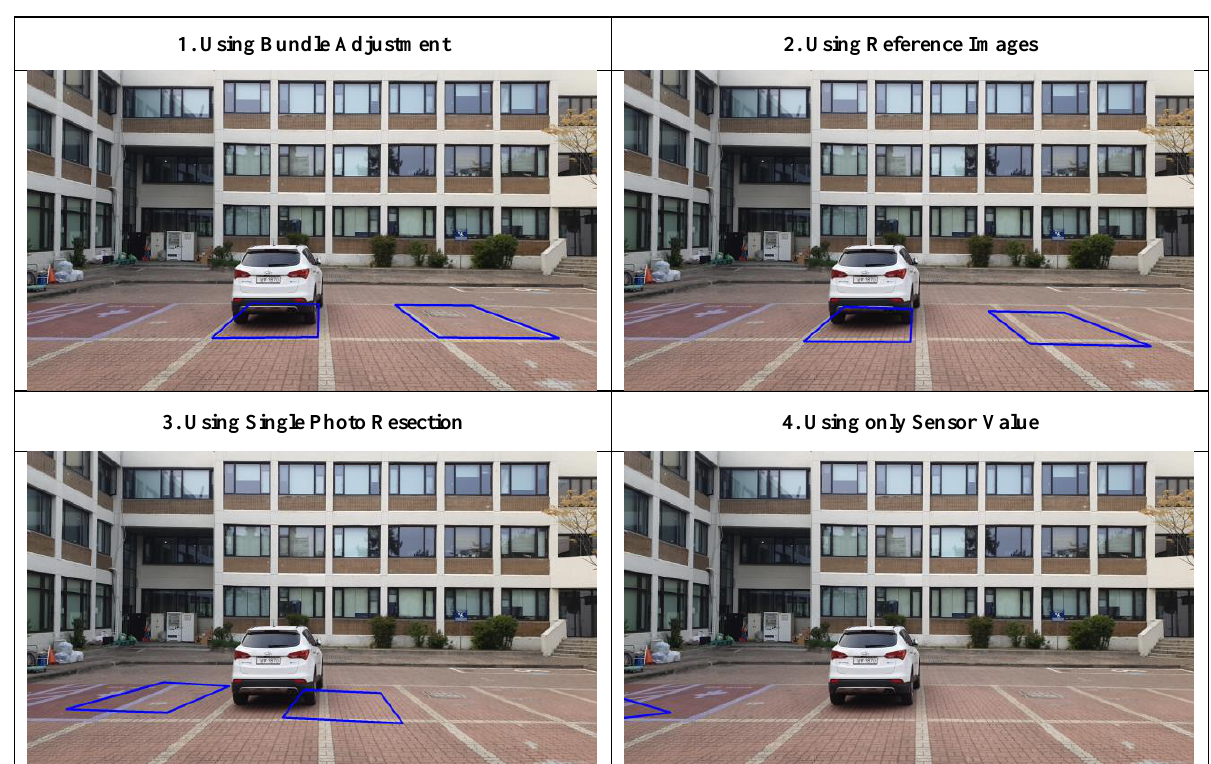
Figure 6. Visualization of the last